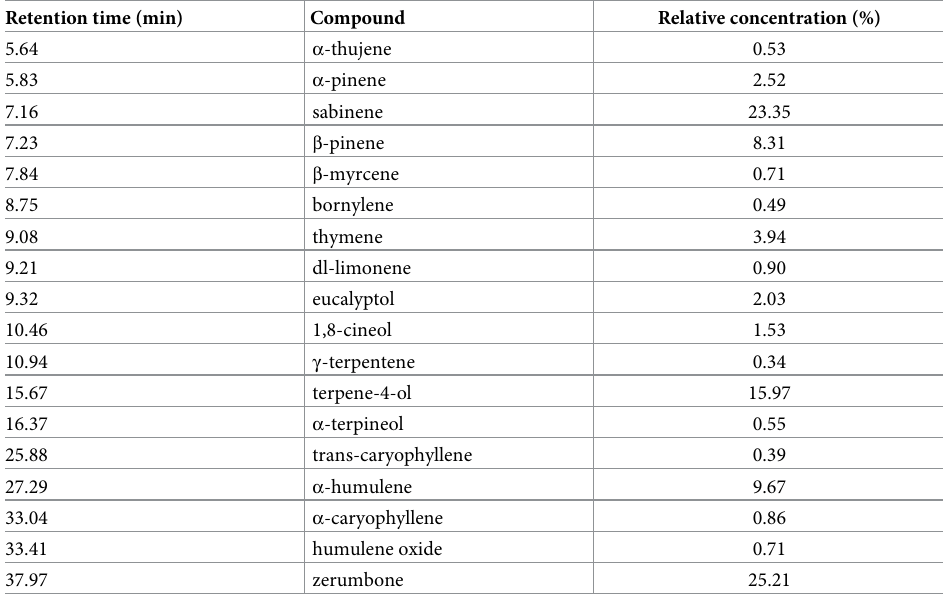
Table 2. Main compounds of ZOEO by GC-MS.